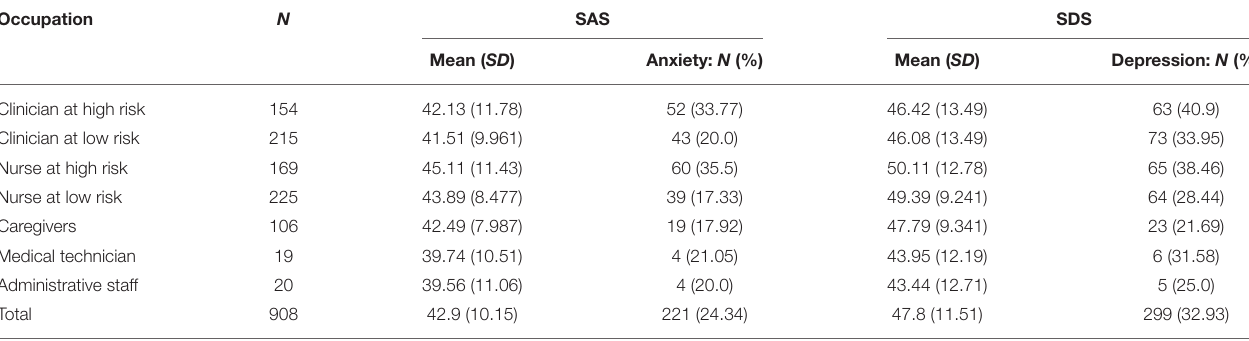
TABLE 2 | SAS and SDS scores in different occupational groups and morbidity of anxiety and depression.